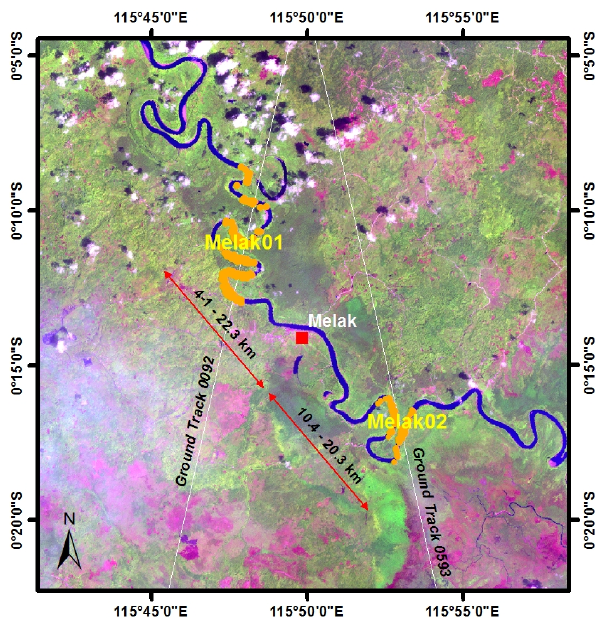
Figure 5. Location of Envisat virtual stations and in situ water level gauge stations at